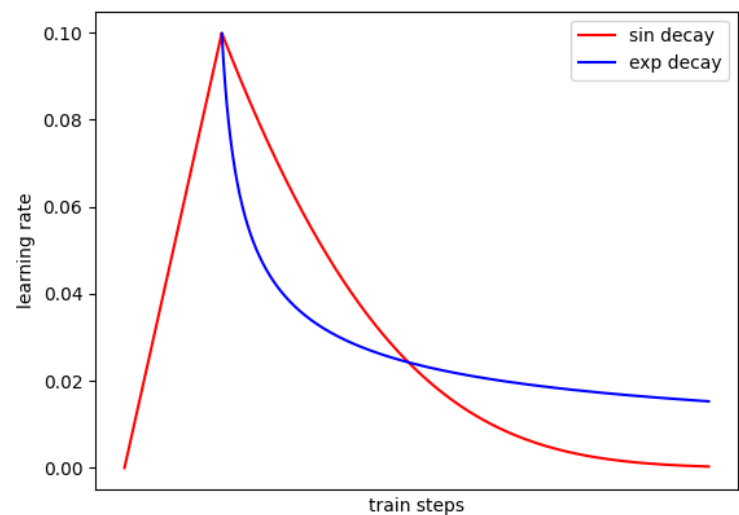
Figure 15. Warmup Learning Rate